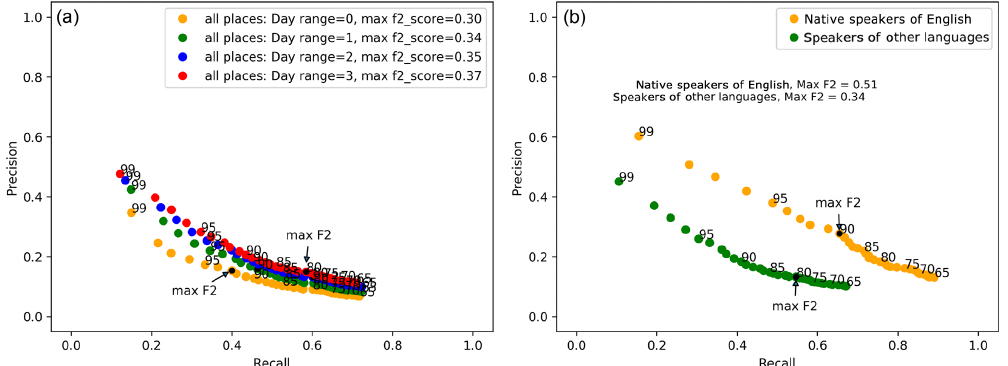
Figure 7. (a) Precision and recall values when comparing tweet data with the Met Office impact database for day 0 only, day + 1, day + 2 and day + 3 from the impact event date. Each point represents the tweet percentile threshold used to signal true and false positive values for an event taking place in the Twitter data. Tweet percentile thresholds tested the range from the 65th percentile to the 99th percentile (step size 1). (b) Precision vs. recall plot for matches (within 3d of event) to Met Office impact event database vs. tweet percentile thresholds 65–99 (step size 1) for countries with native speakers of English countries vs. countries with speakers of other languages.